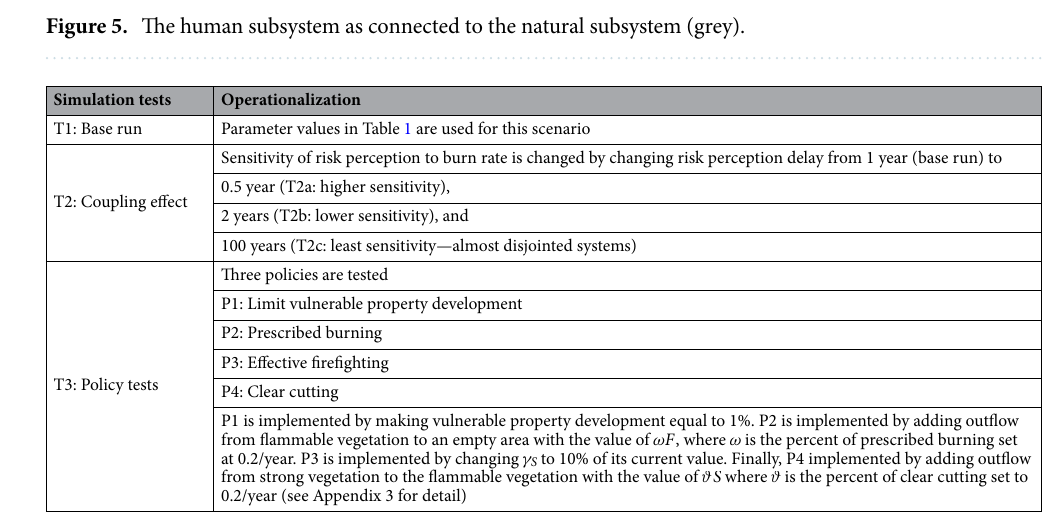
Table 2. Simulation